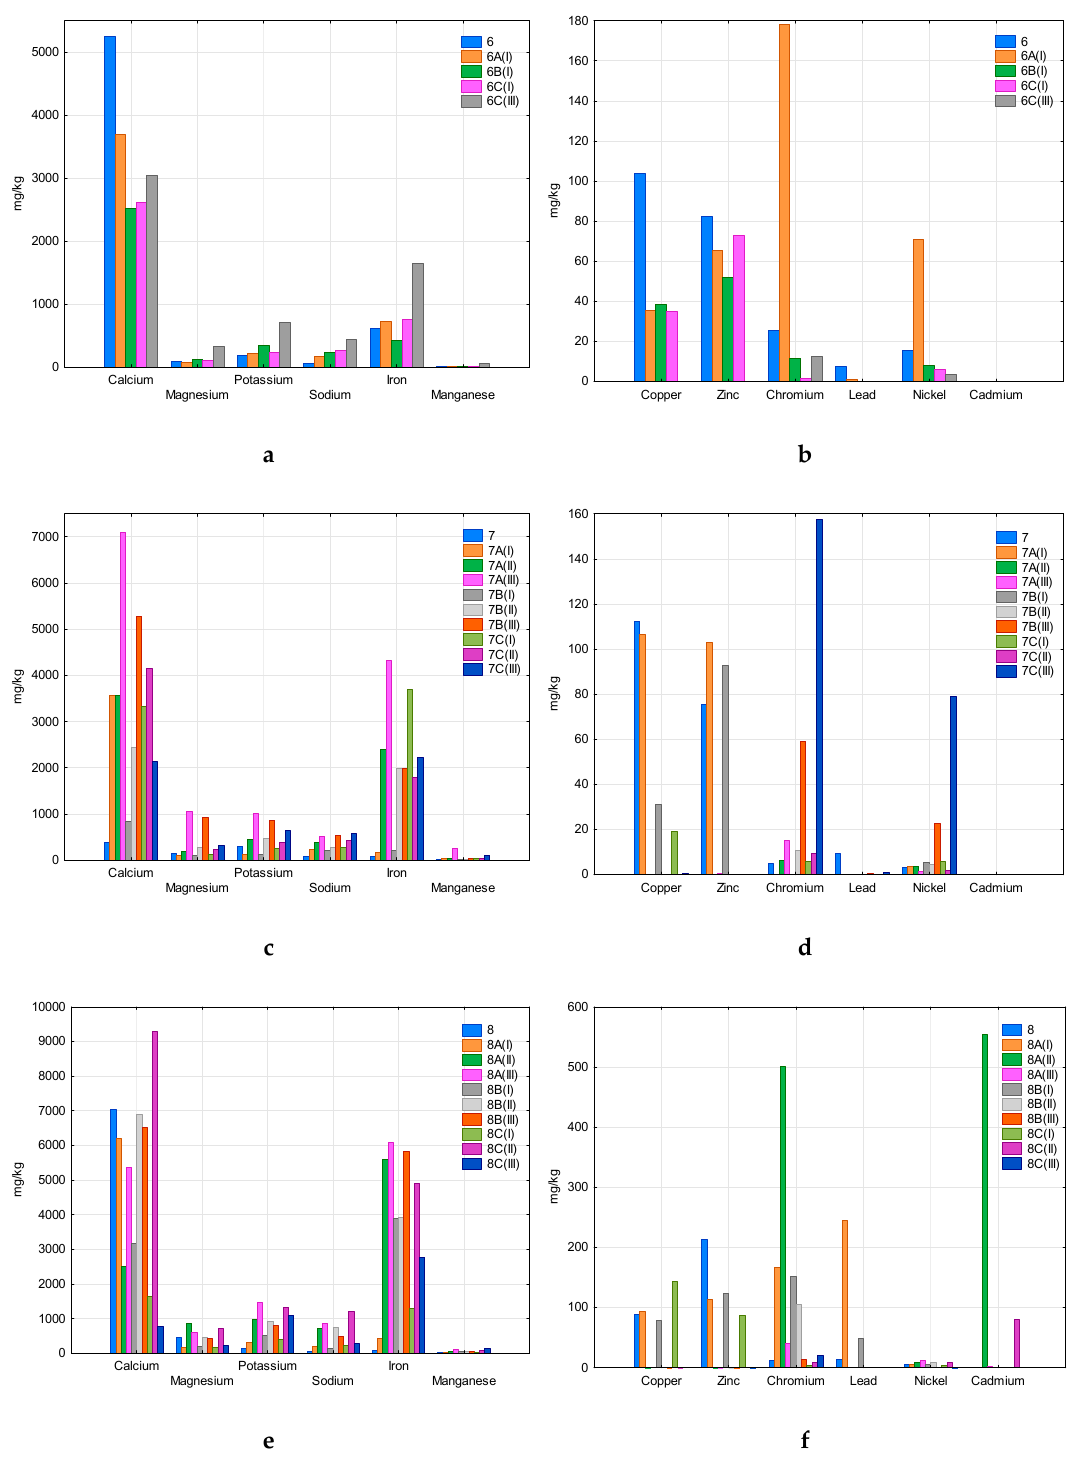
Figure 4. Comparison of the content of analysed metals in new and composted samples 6 ( a —macroelements, b —heavy metals), 7 ( c —macroelements, d —heavy metals), and 8 ( e —macroelements, f —heavy metals)